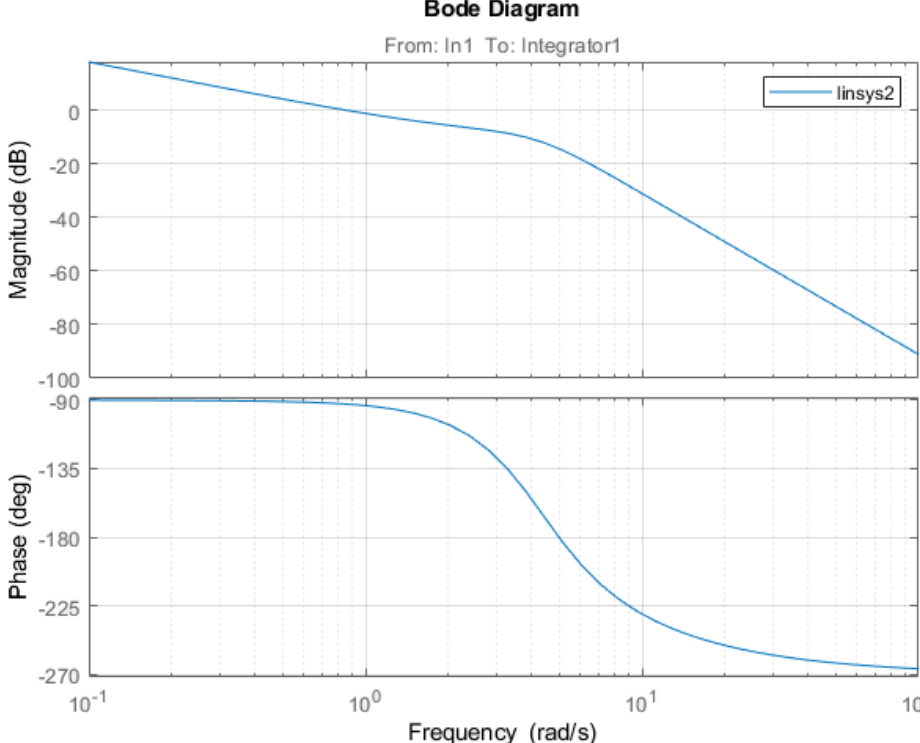
Figure A2. Frequency characteristics of the speed open loop.